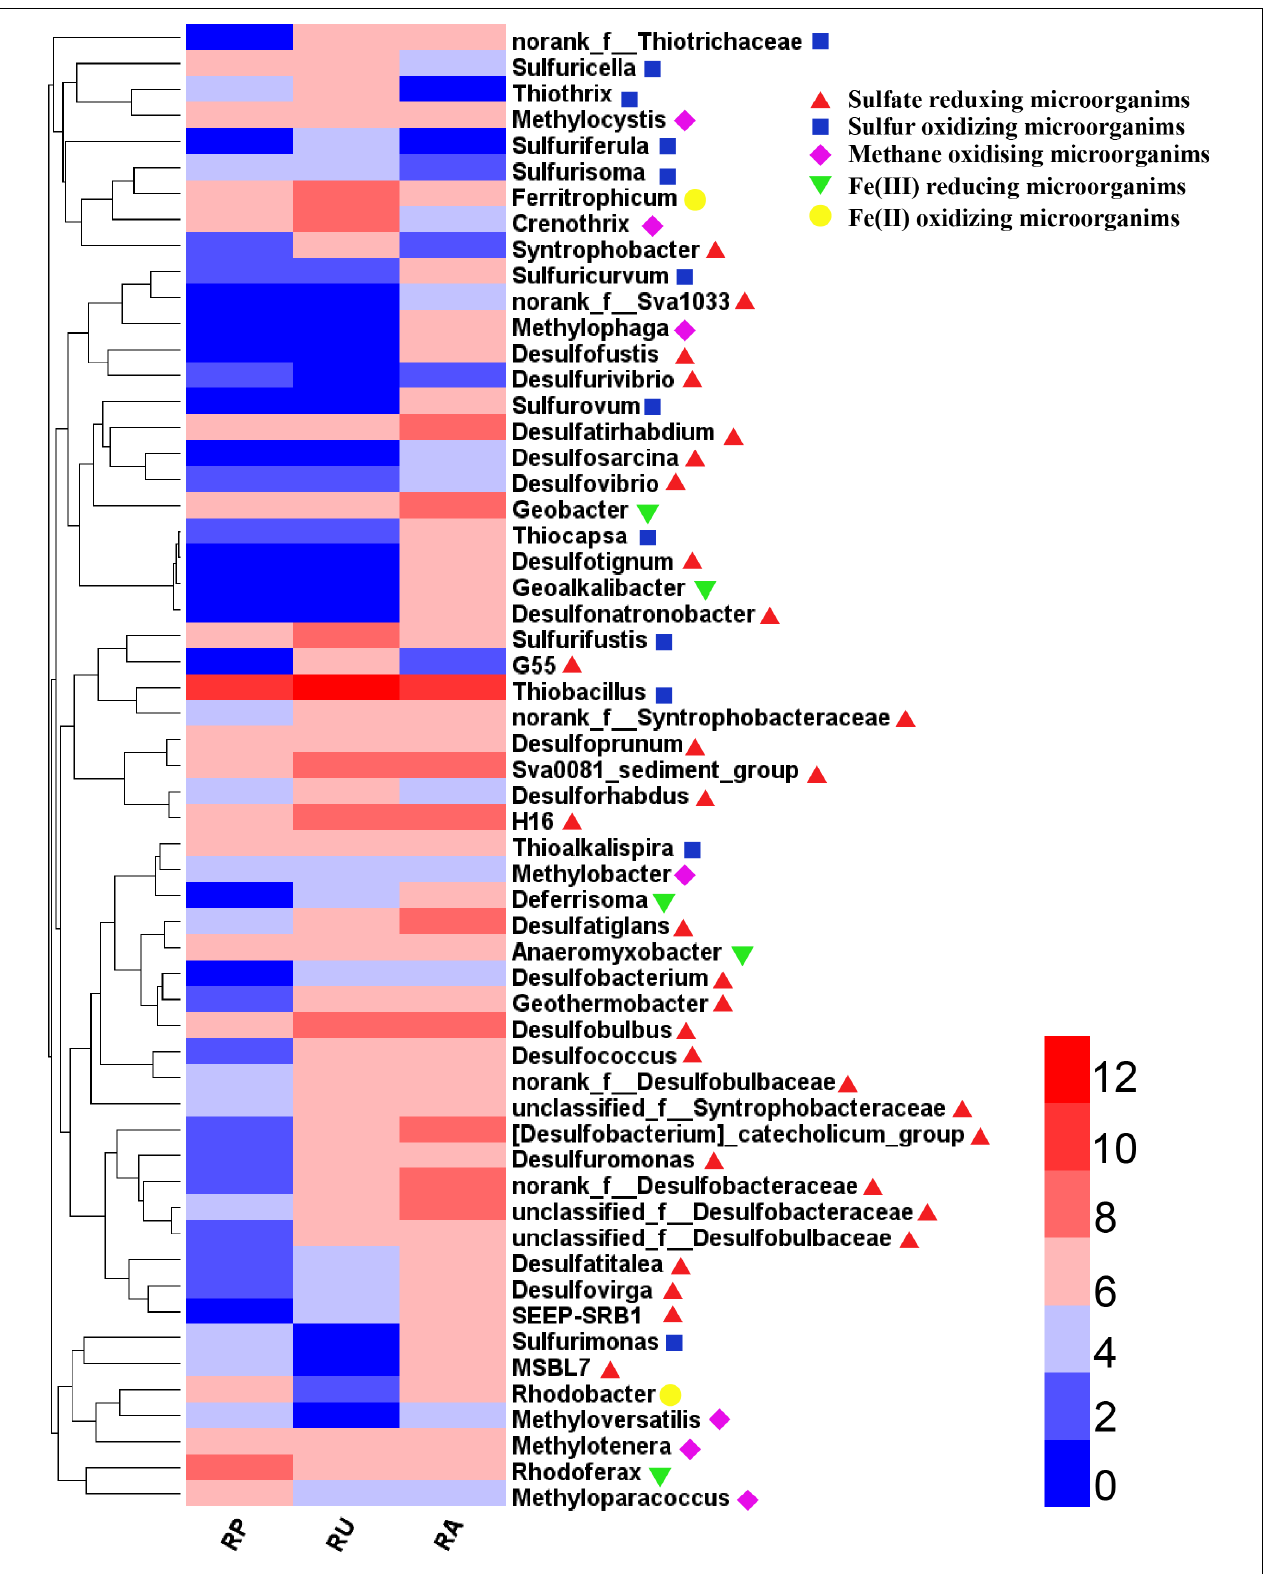
FIGURE 3 | Heatmap of genera in odorous river sediments with different types of human intervention. Colored bars indicate the abundance normalized on a log2 scale, based on the color key at the top right.